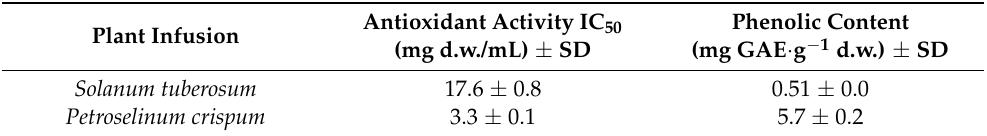
Table 1. Antioxidant capacity and TPC of plant infusions. Plant